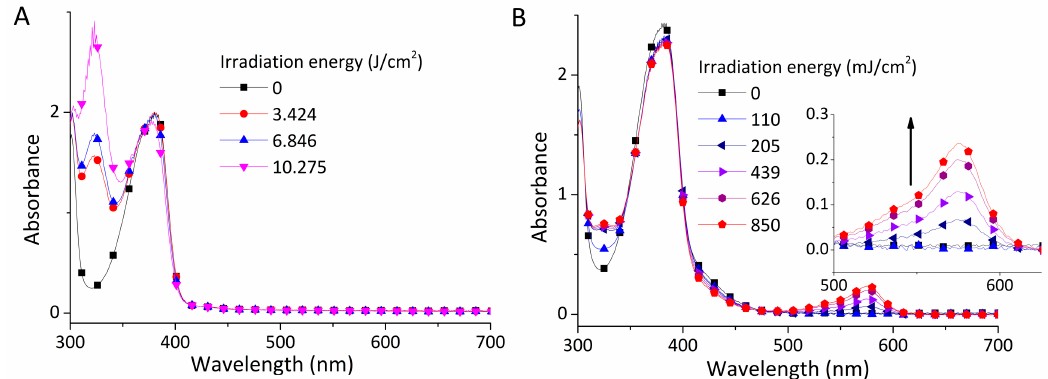
Figure 2. UV–Vis spectra of the TX solution (10 − 4 M) without ( A ) and with ( B ) the addition of phenol red under irradiation at different light doses.